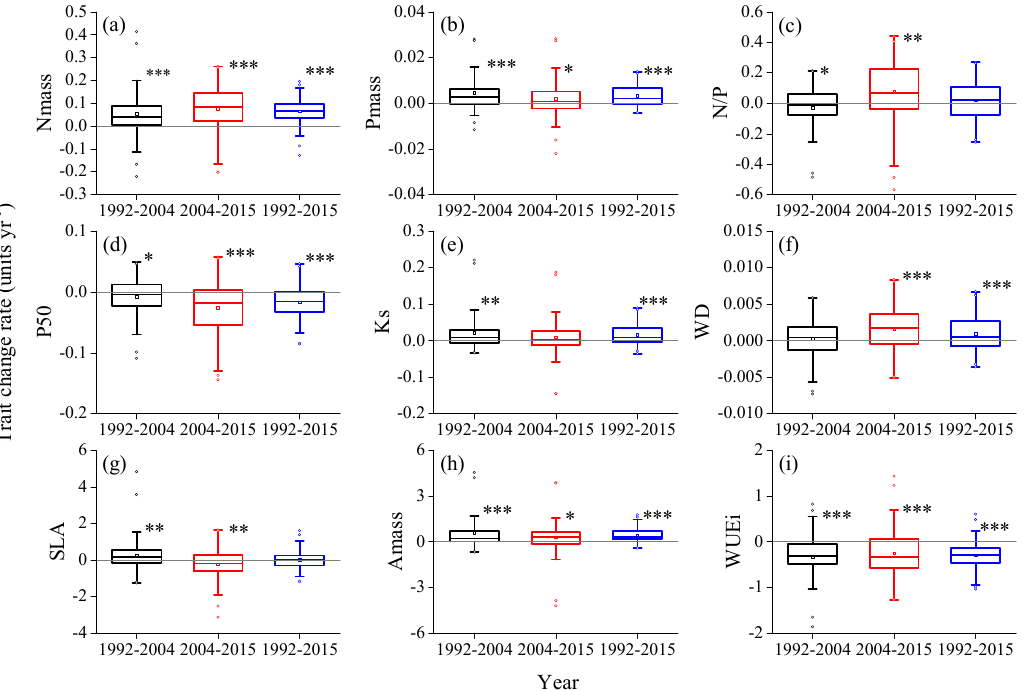
Figure 2. Annual rates of change in quadrats’ trait values in periods of 1992–2004, 2004–2015, and 1992–2015. (a) leaf nitrogen concentration per unit mass (Nmass, mg g − 1 ); (b) leaf phosphorus concentration per unit mass (Pmass, mg g − 1 ); (c) leaf nitrogen to phosphorus ratio per unit mass (N/P,); (d) the pressure causing 50% loss of stem hydraulic conductivity (P50, MPa); (e) sapwood-specific hydraulic conductivity (Ks, kg m − 1 s − 1 MPa − 1 ); (f) sapwood density (WD, g cm − 3 ); (g) specific leaf area (SLA, cm 2 g − 1 ); (h) maximum CO 2 assimilation rate per unit mass (Amass, nmol g -1 s -1 ); (i)